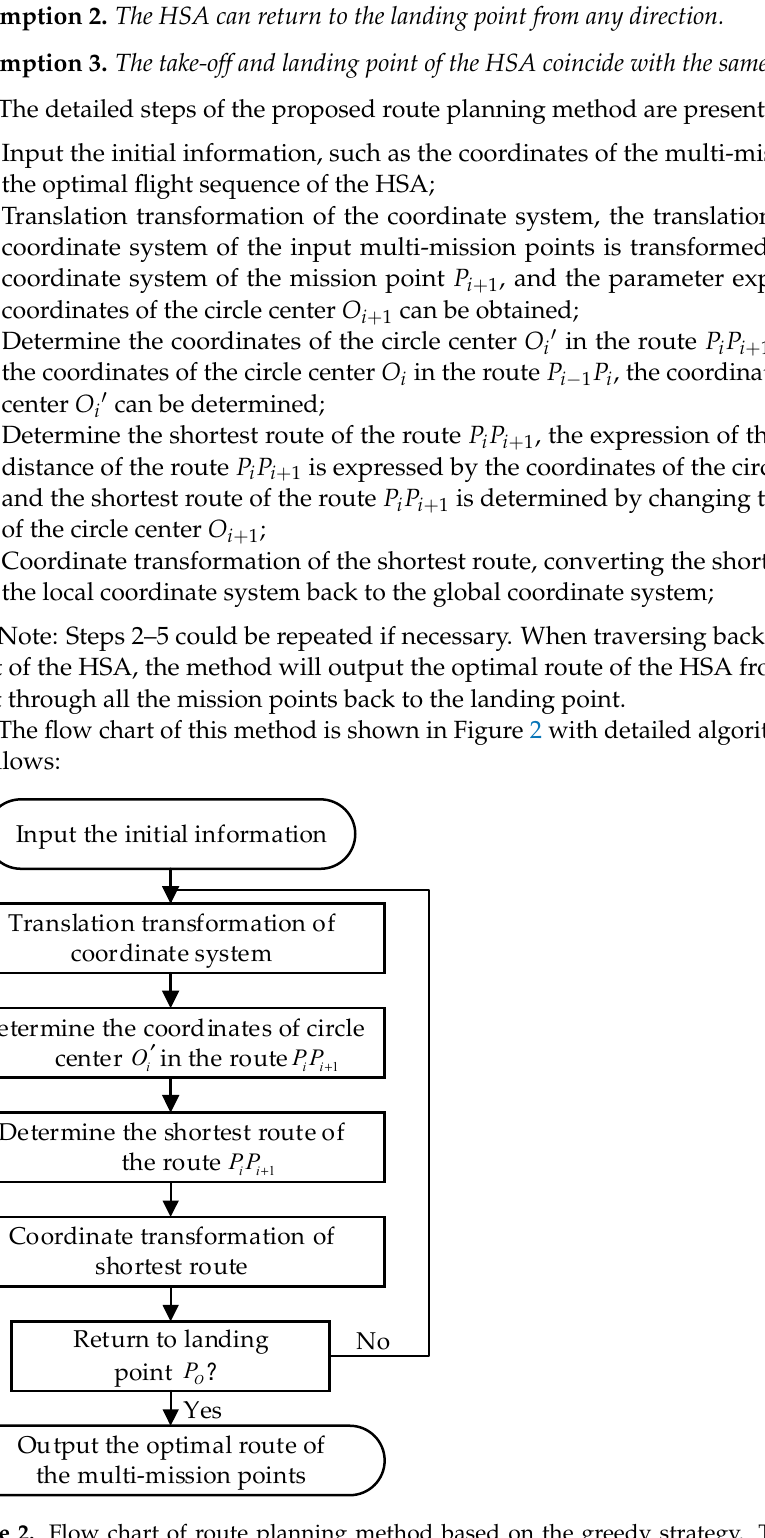
Figure 2. Flow chart of route planning method based on the greedy strategy. The initial input information includes the coordinates of the multi-mission points of the optimal flight sequence of the HAS and the coordinates of the circle center O of the take-off point P O